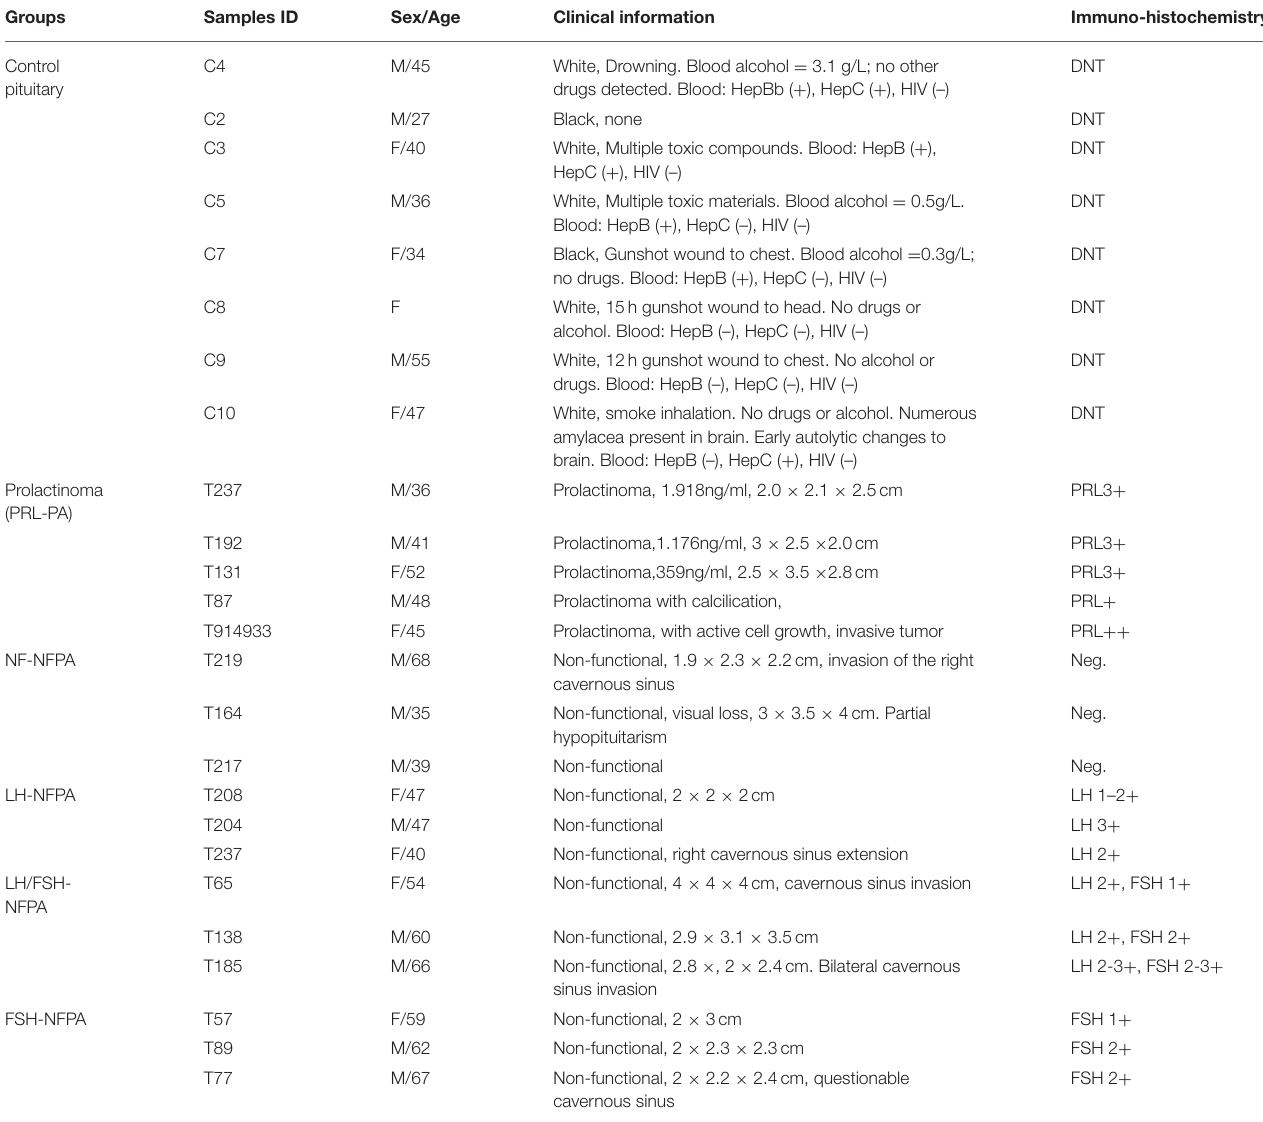
TABLE 2 | Clinical information of human pituitaries and pituitary adenomas.